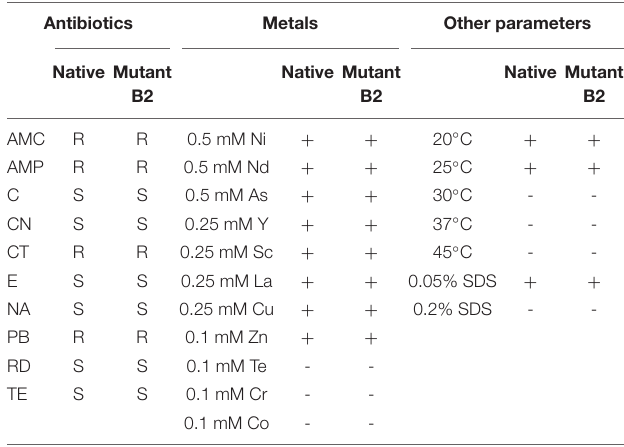
TABLE 2 | Growth of native and mutant strains in different conditions (antibiotics, metals, and other parameters).